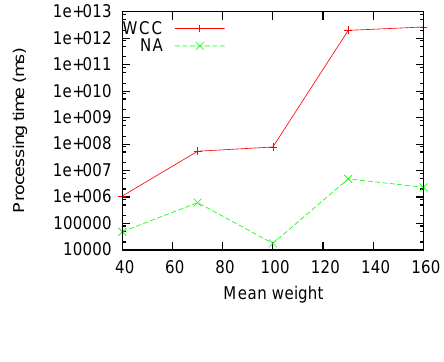
Figure 5. Processing time sensitivity to mean ( w )